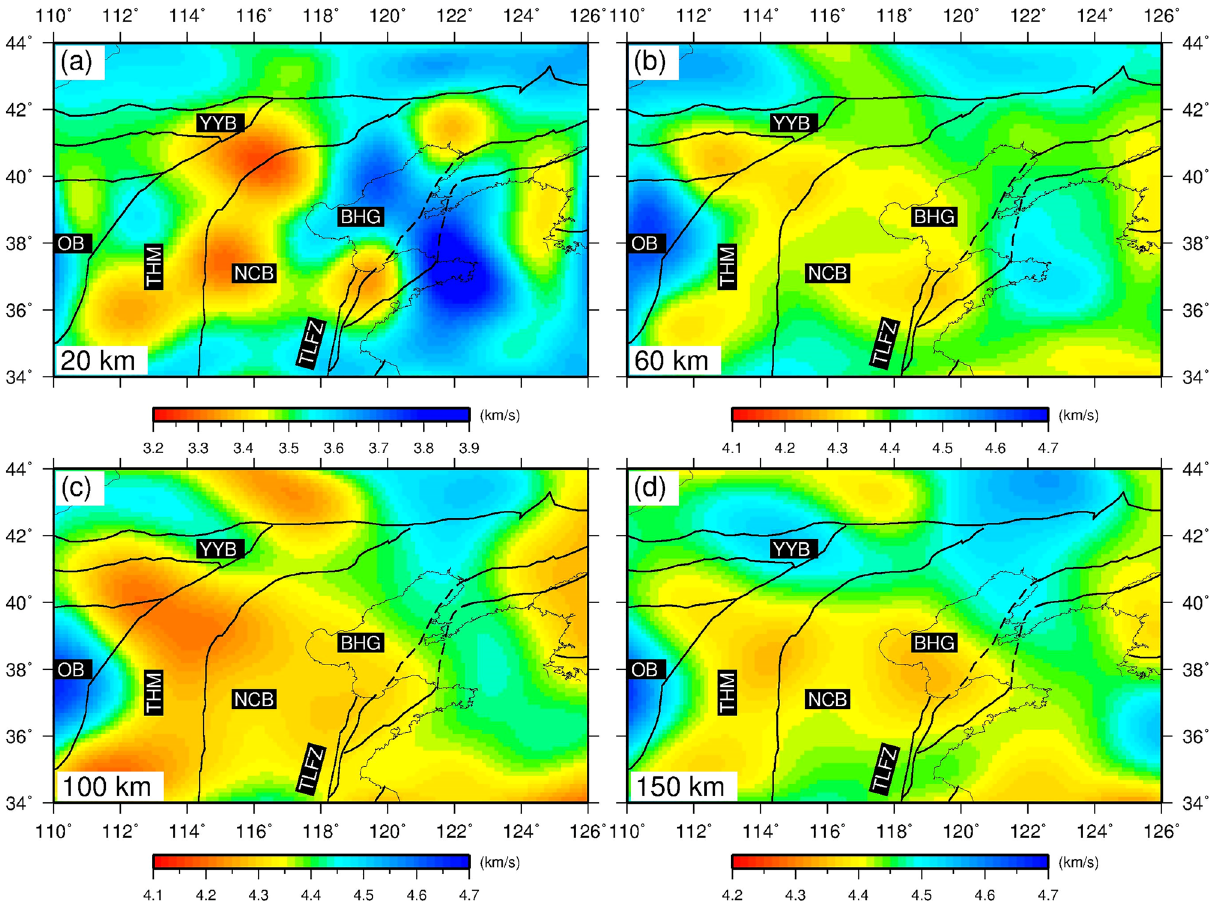
Figure 2. Map views of Sv-wave velocity at four depths. ( a ) 20 km, ( b ) 60 km, ( c ) 100 km and ( d ) 150 km. The map in the figure was generated by the Generic Mapping Tools package 115 (GMT-4.5.9, https:// www. gener ic- mappi ng- tools.